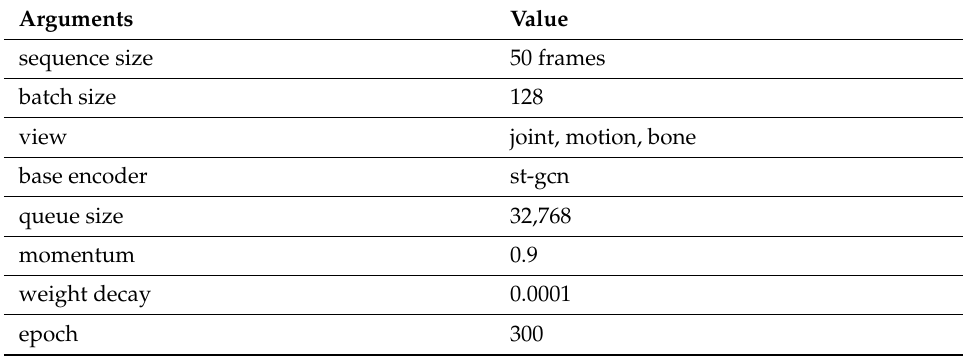
Table 1. Experimental arguments